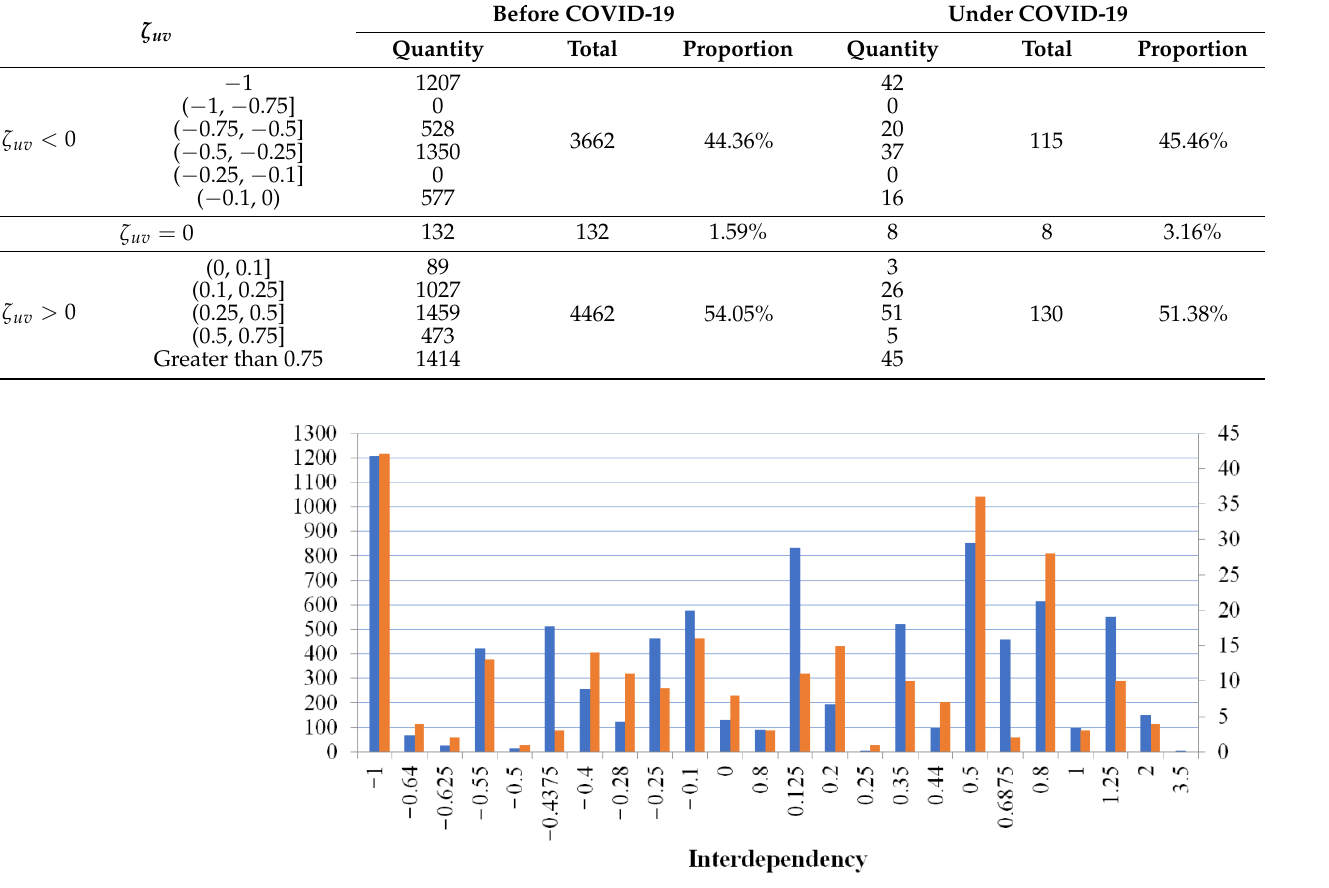
Table 2. Results of the interdependencies between the urban functions before and under the lockdown of COVID-19.